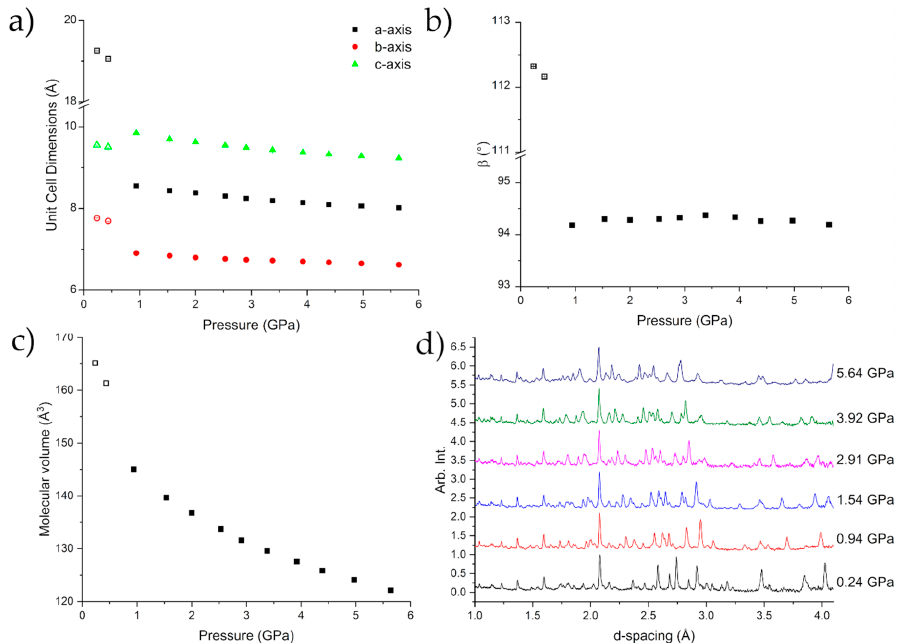
Figure 6. Compression of the unit cell dimensions ( a , b & d ) indicating the phase transition to Form III caprolactam. There is a discontinuity in the molecular volume over the transition ( c ). The error bars are smaller than the symbols.